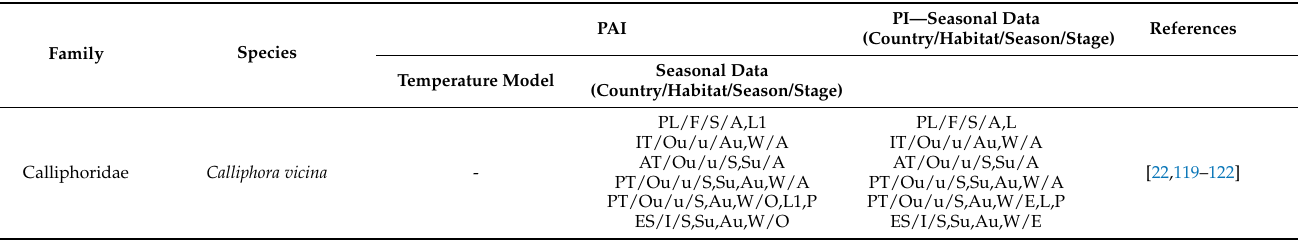
Table 3. Datasets on the pre-appearance interval (PAI) and the presence interval (PI) of the species that breed in large vertebrate cadavers in central Europe (species list compiled based on [20–25]). I reviewed datasets derived from experiments performed in Europe and on pig cadavers